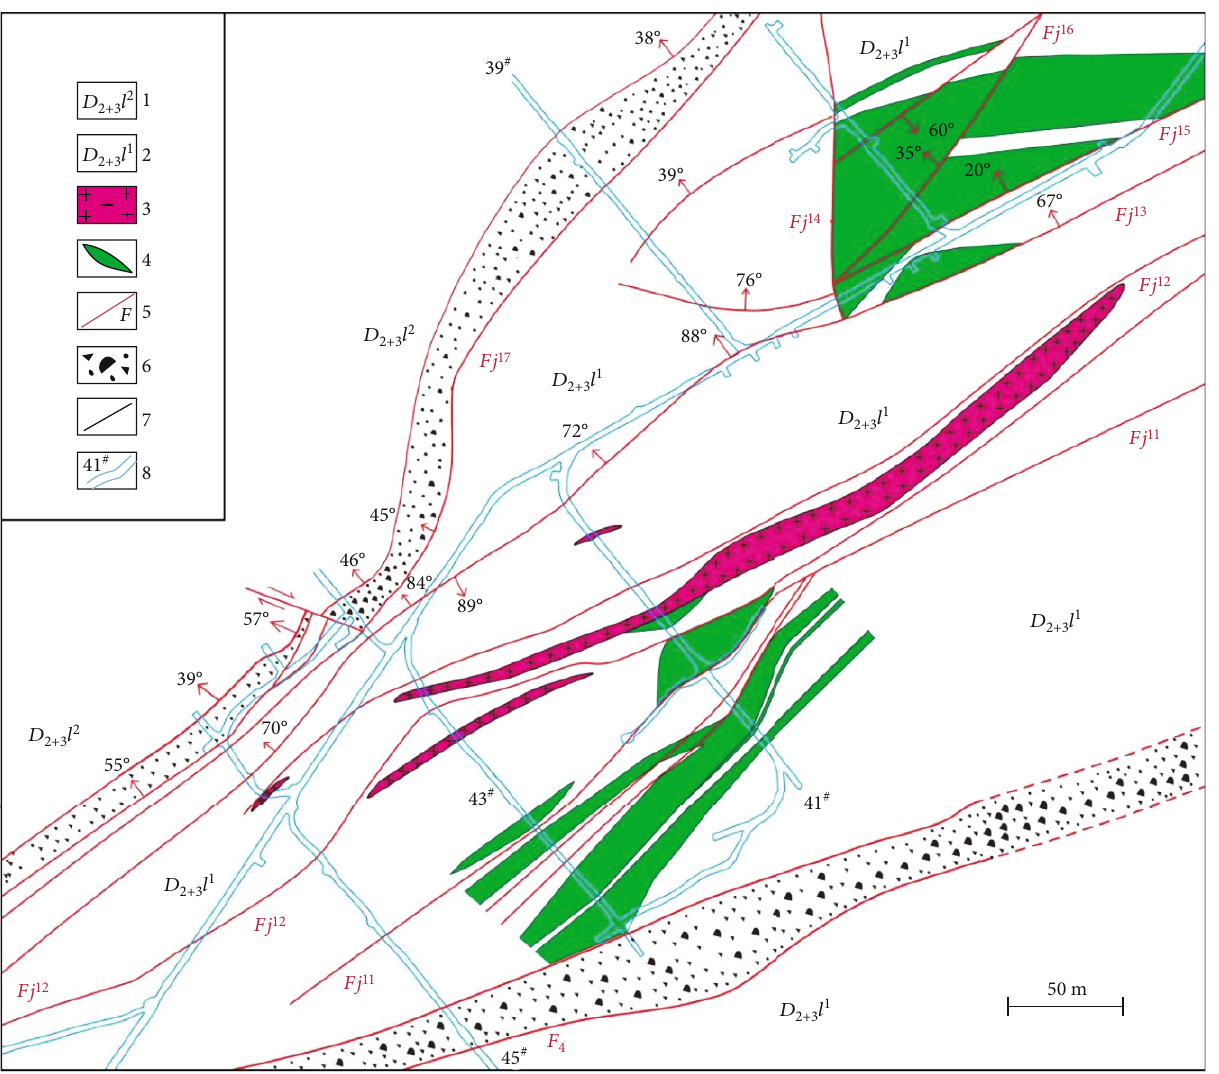
Figure 4: The underground tunnel 3,250m section map of the Yangla copper deposit, Yunnan, China. 1: Devonian (Linong Formation); 2: Devonian (Jiangbian Formation); 3: granitic porphyry; 4: copper ore body; 5: fault and corresponding number; 6: fracture zone; 7: geological boundary line; and 8: tunnel and corresponding